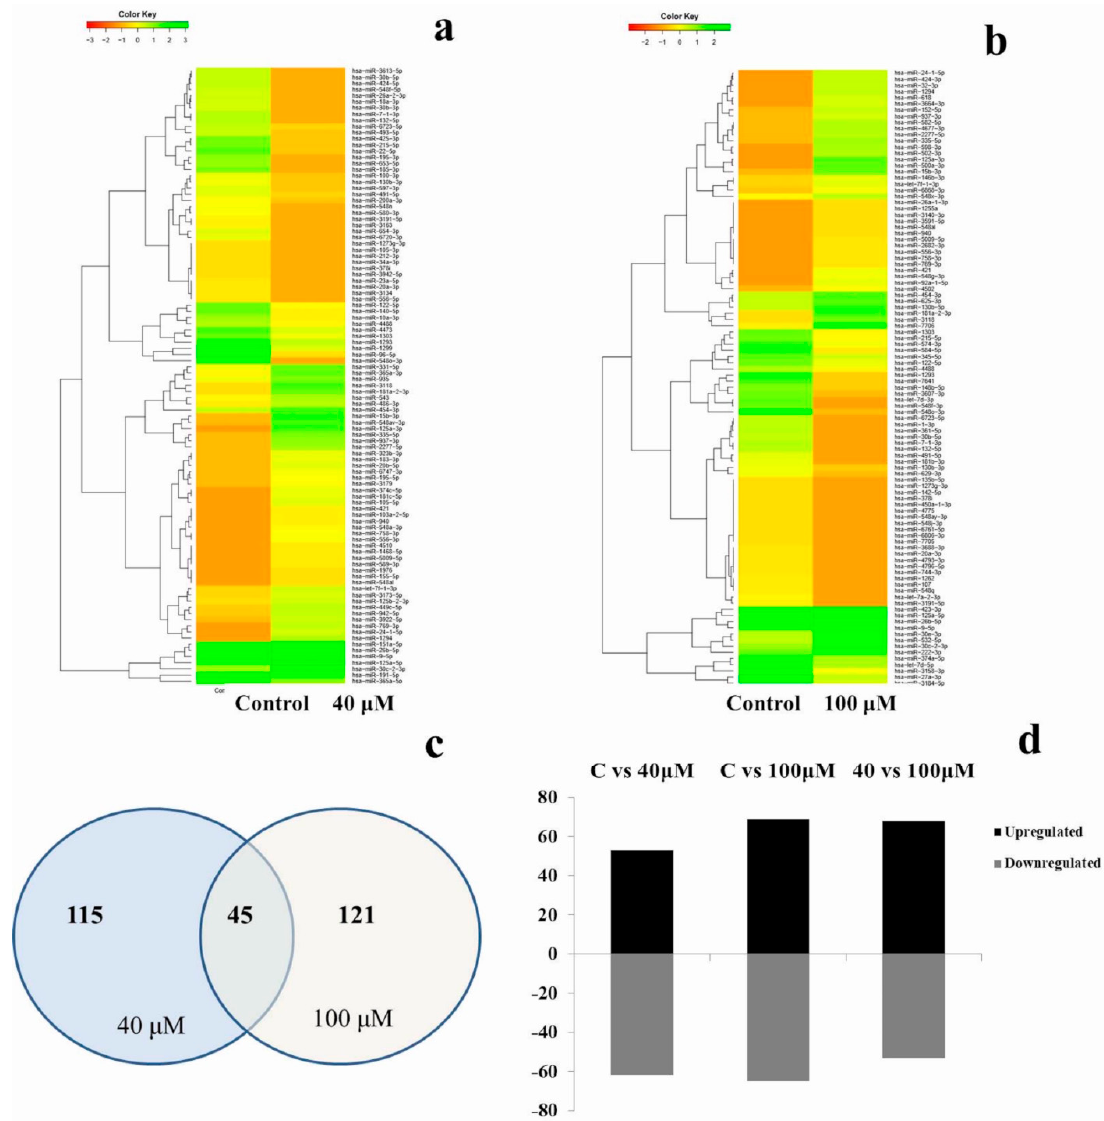
Figure 6. Dose-dependent microRNA expression profiles of top 100 microRNAs. ( a ) Relative microRNA expression levels in untreated control vs. 40 µ M EGCG treatment; ( b ) Relative microRNA expression levels in untreated control vs. 100 µ M EGCG treatment; ( c ) Venn diagram depicting the dose-dependent responses of microRNAs to EGCG; ( d ) Summary set of up- and down-regulated microRNAs exhibiting greater than 2 log2-fold change expression after EGCG treatments. Color key- red: up-regulation, green: down-regulation and yellow: neutral expression.